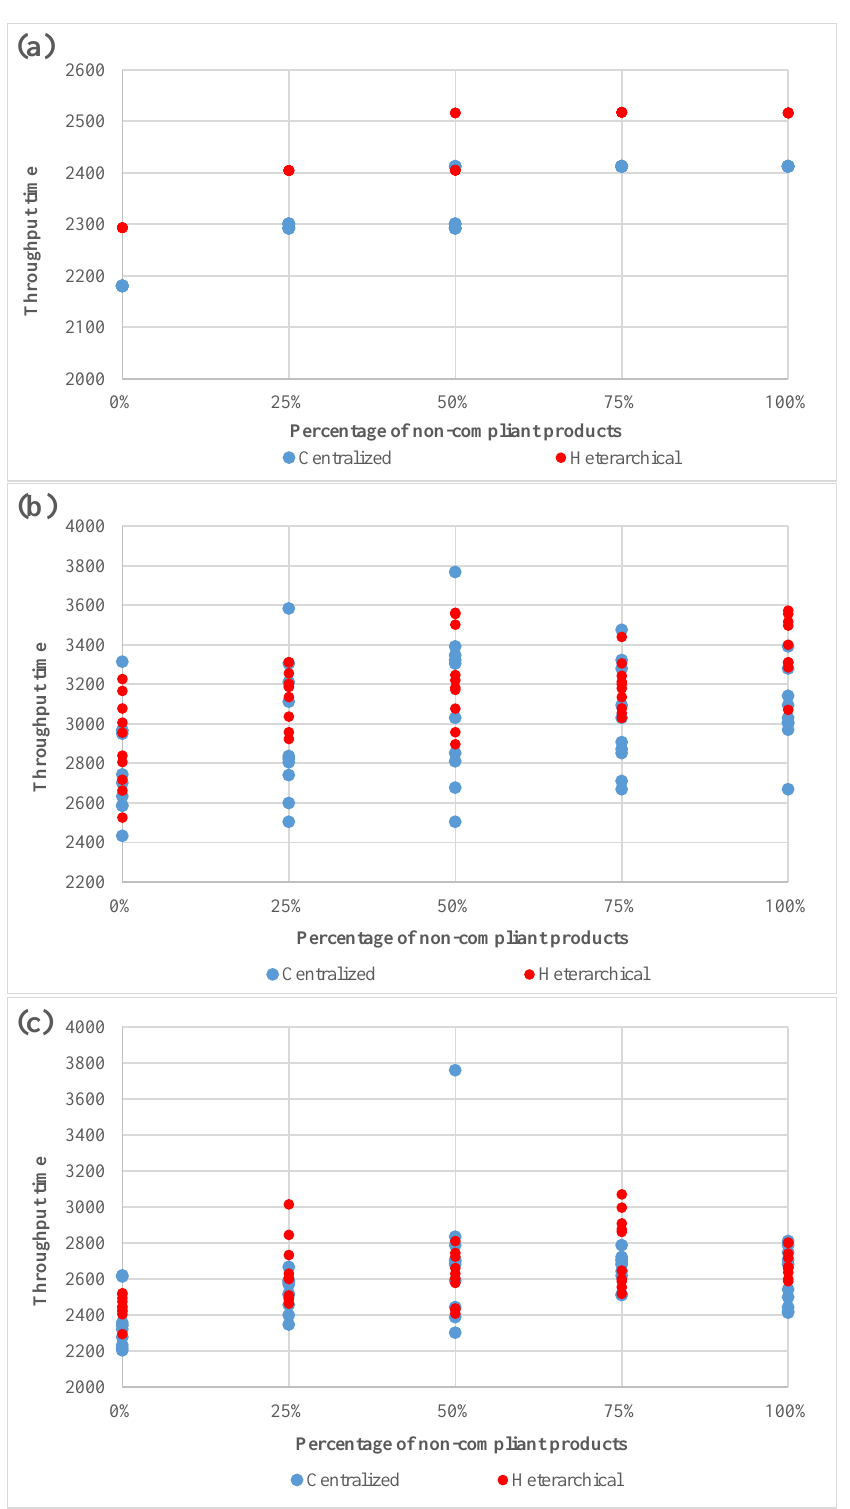
Figure 7. Simulation results for the material handling system control; ( a ) No AGV failures; ( b ) AGV failures: MTBF = 3 min and MTTR = 1 min; ( c ) AGV failures: MTBF = 9 min − MTTR = 1